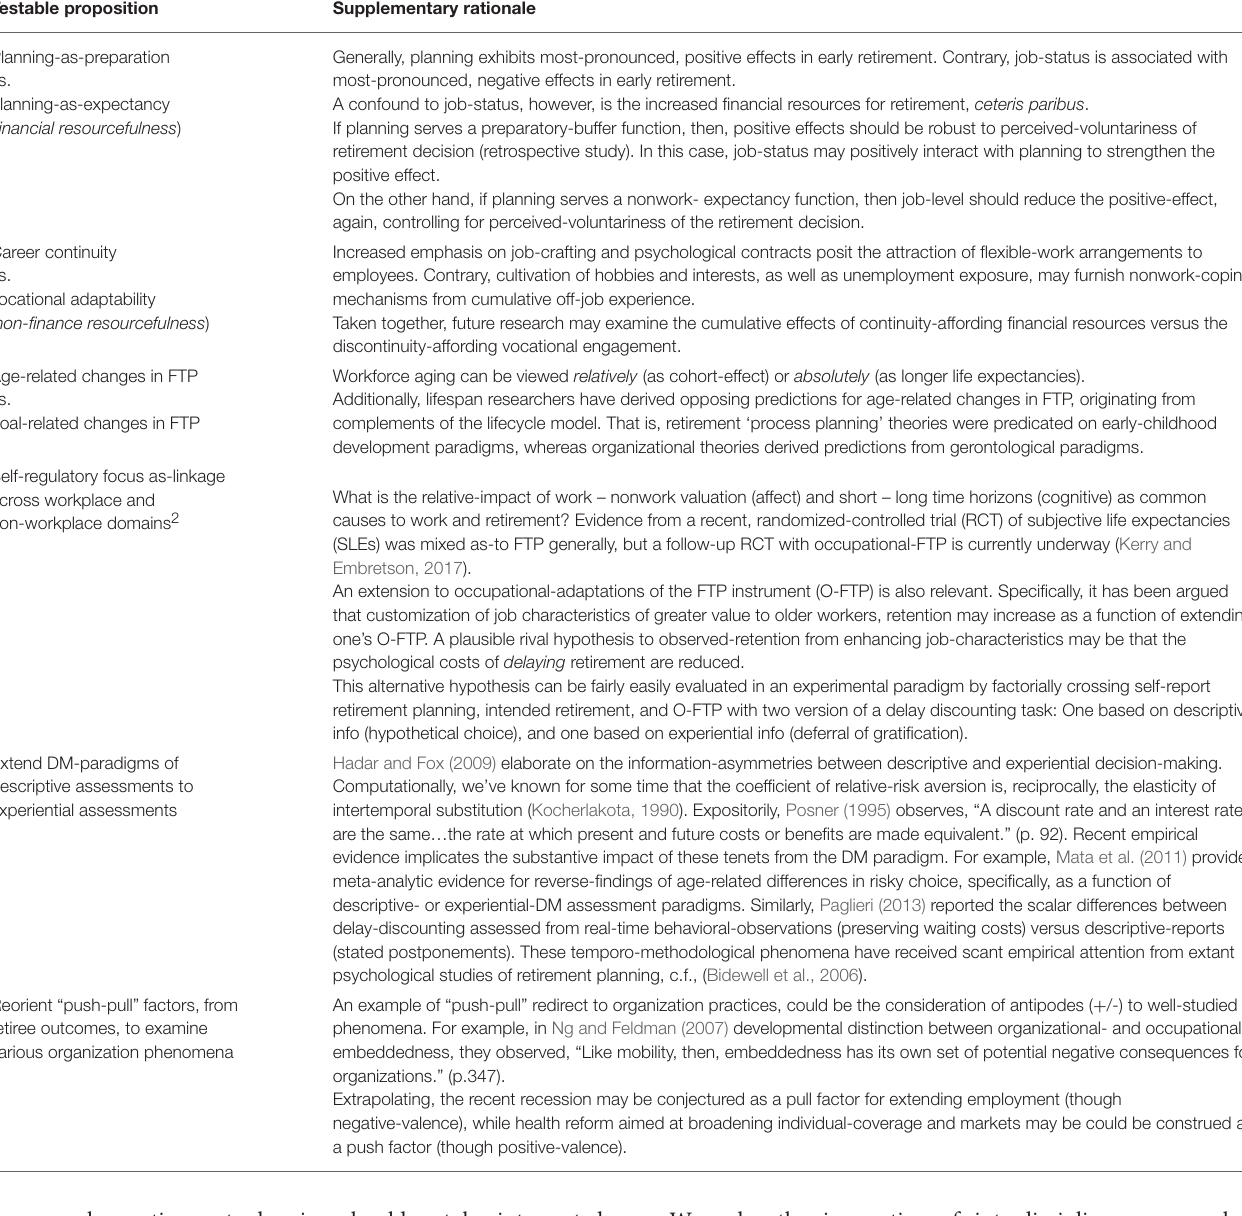
TABLE 5 | Summary-plausible rival explanatory propositions and provocations for advancing future empirical research on retirement